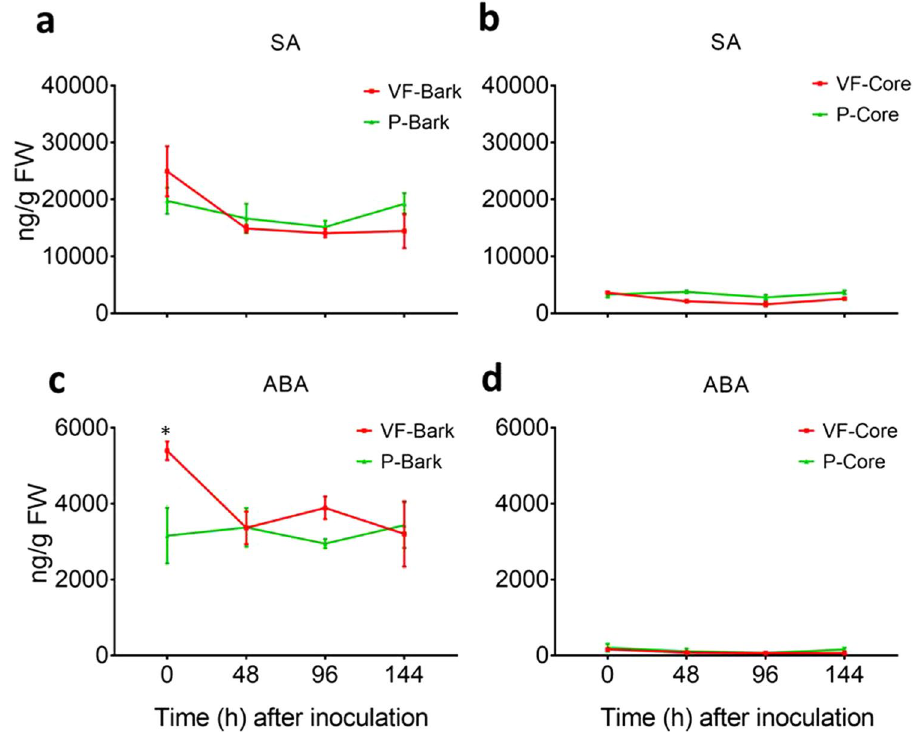
Figure 5. Levels of salicylic acid (SA) and abscisic acid (ABA) in the inoculated stem tissues of ‘Valley Forge’ and ‘Princeton’. ( a , b ) The level of SA (ng/g FW) in the bark and core tissues, respectively, of ‘Valley Forge’ (VF) and ‘Princeton’ (P) at 0, 48, 96 and 144 hpi. ( c , d ) the level of ABA (ng/g FW) in the bark and core tissues, respectively, of ‘Valley Forge’ (VF) and ‘Princeton’ (P) at different time points of inoculation with the fungus. The results are the mean ± SE of three biological replicates. Values marked with an asterisk ( * ) are